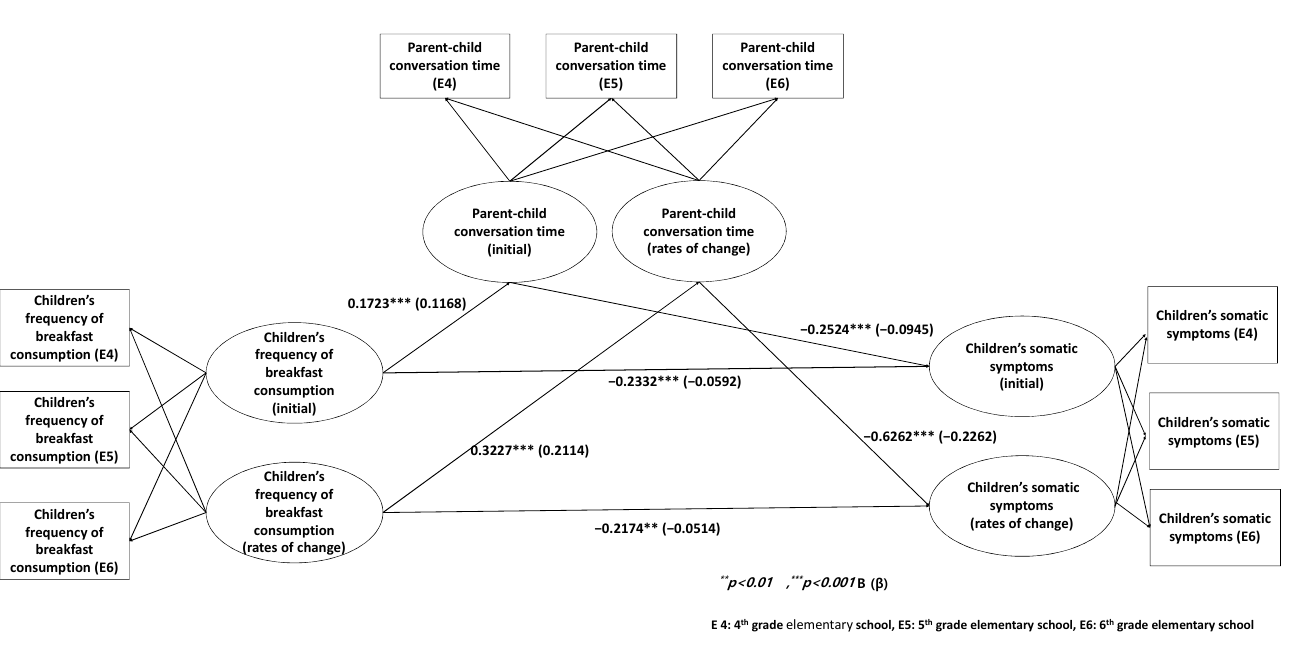
Figure 2. Final Model Figure 2. The results of latent growth analysis in the frequency of breakfast consumption, the amount of parental-child conversation time and somatic symptoms. Table 5. Verification of the research